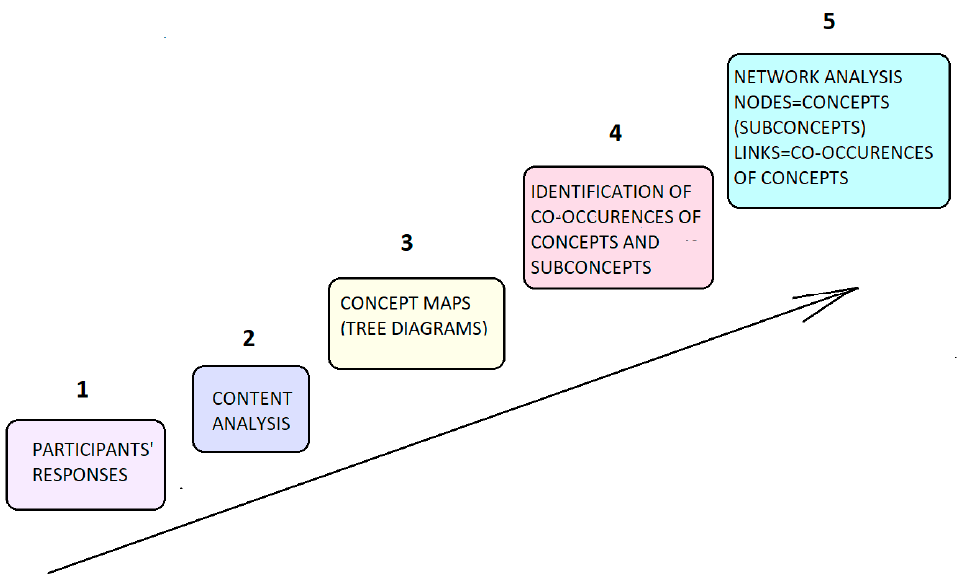
Figure 1. The five phases of the research project. Table 1. Age groups with number of participants per group, mean age, and standard deviation. Ages Participants Mean